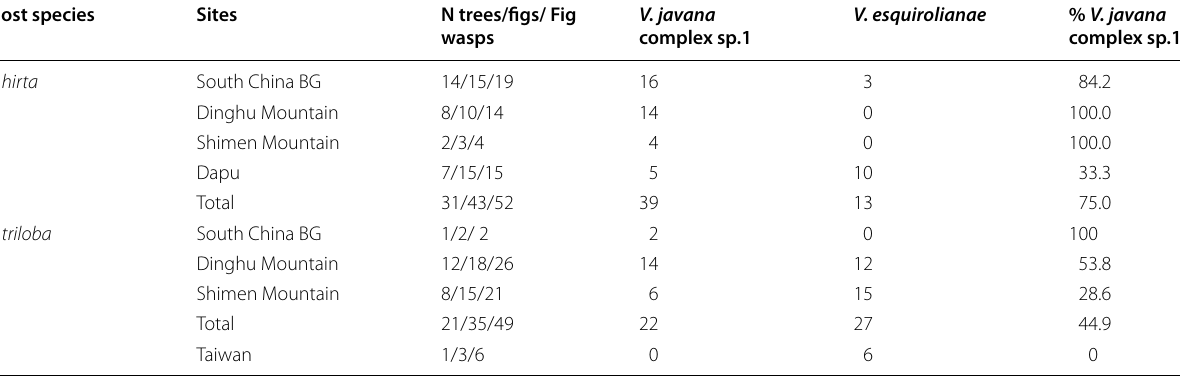
Table 1 The presence of adult offspring of Valisia javana complex sp.1 and Valisia esquirolianae in male figs of Ficus hirta and F. triloba collected from Guangdong province, China and Taiwan